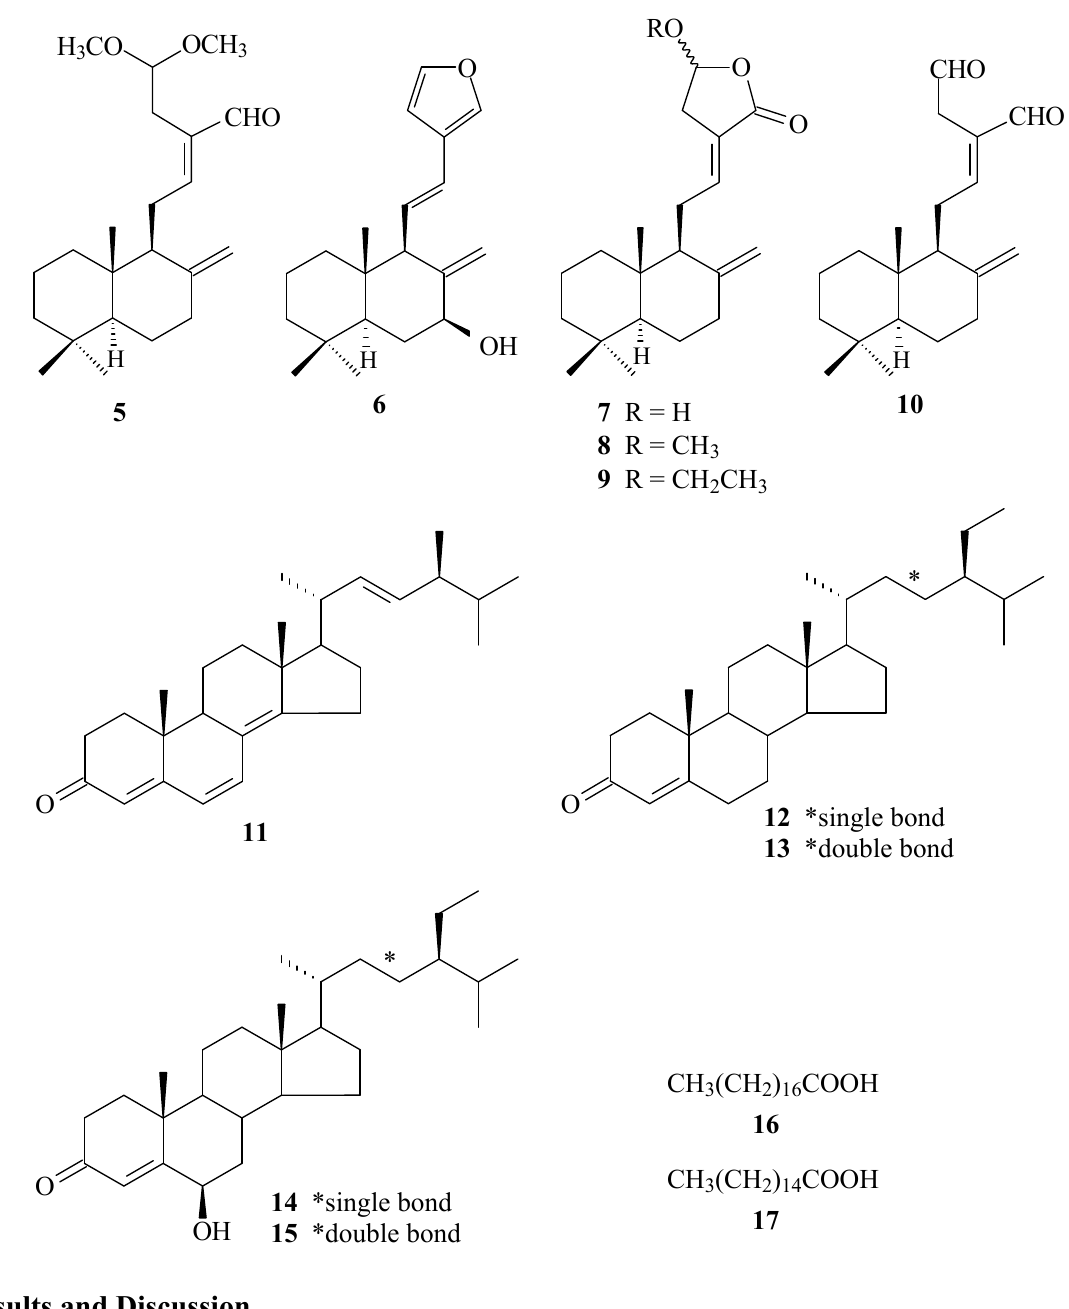
Figure 2. The chemical structures of known compounds 5 – 17 isolated from H. coronarium